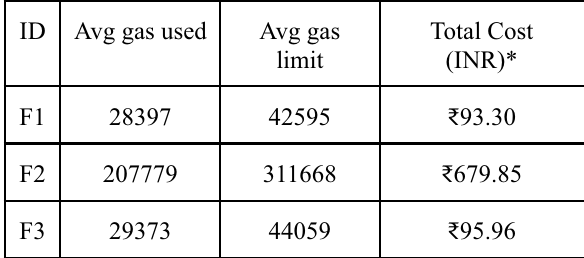
Table 3. Average approximate costs across the smart contracts’